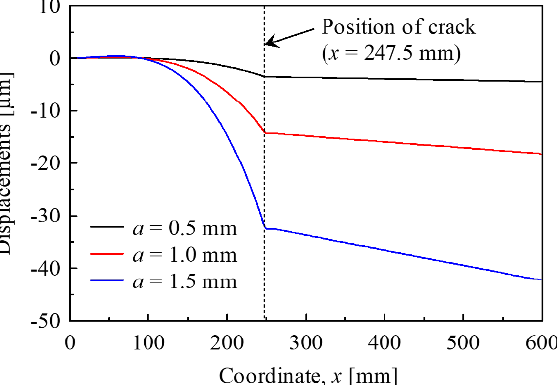
change in the z -direction due to loading.